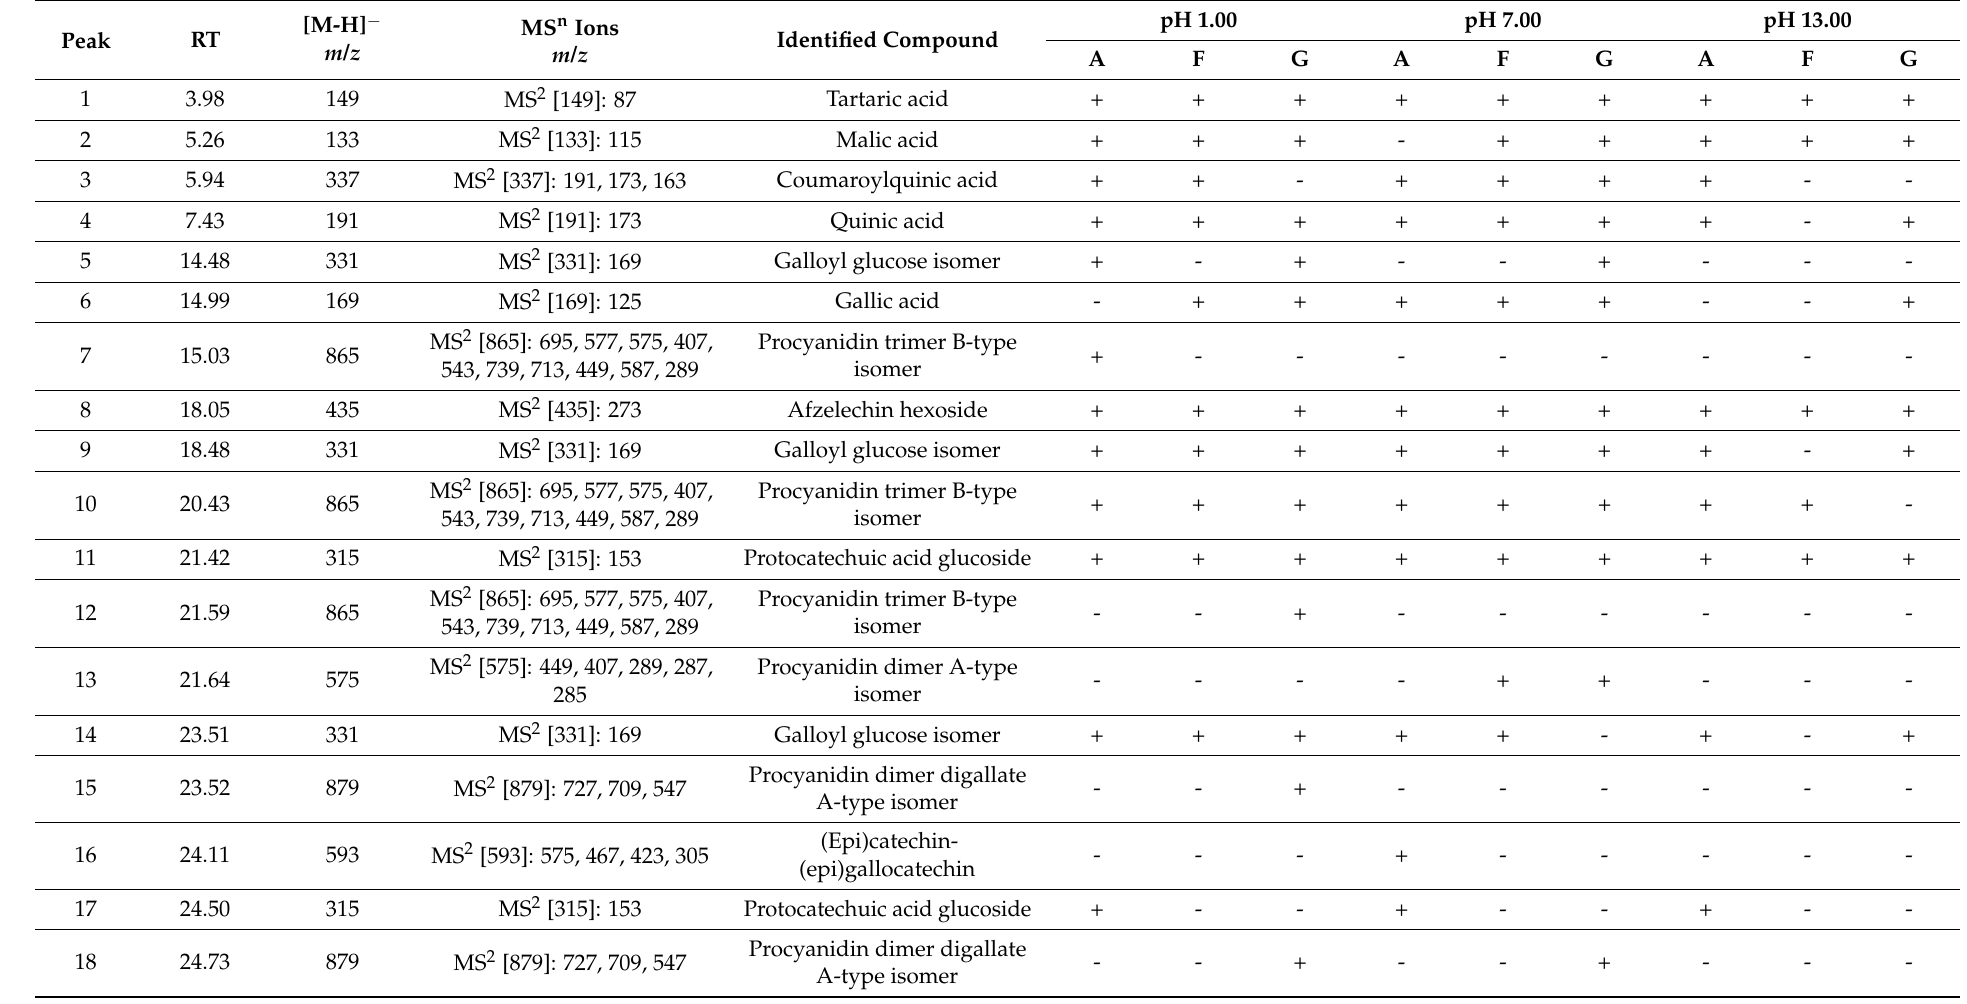
Table 1. List of phenolic compounds identified by HPLC-UV and HPLC-ITMS n in “Aglianico” (A), “Fiano” (F), and “Greco” (G) grape canes extracted at pH 1.00, 7.00, and 13.00. Specific quasi-molecular ions and fragment ions are reported for each compound.